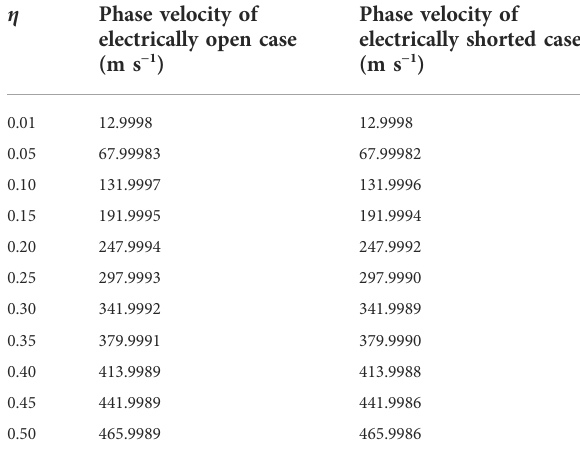
FIGURE 2 Dispersion curves of localized bending waves for different plate theories.